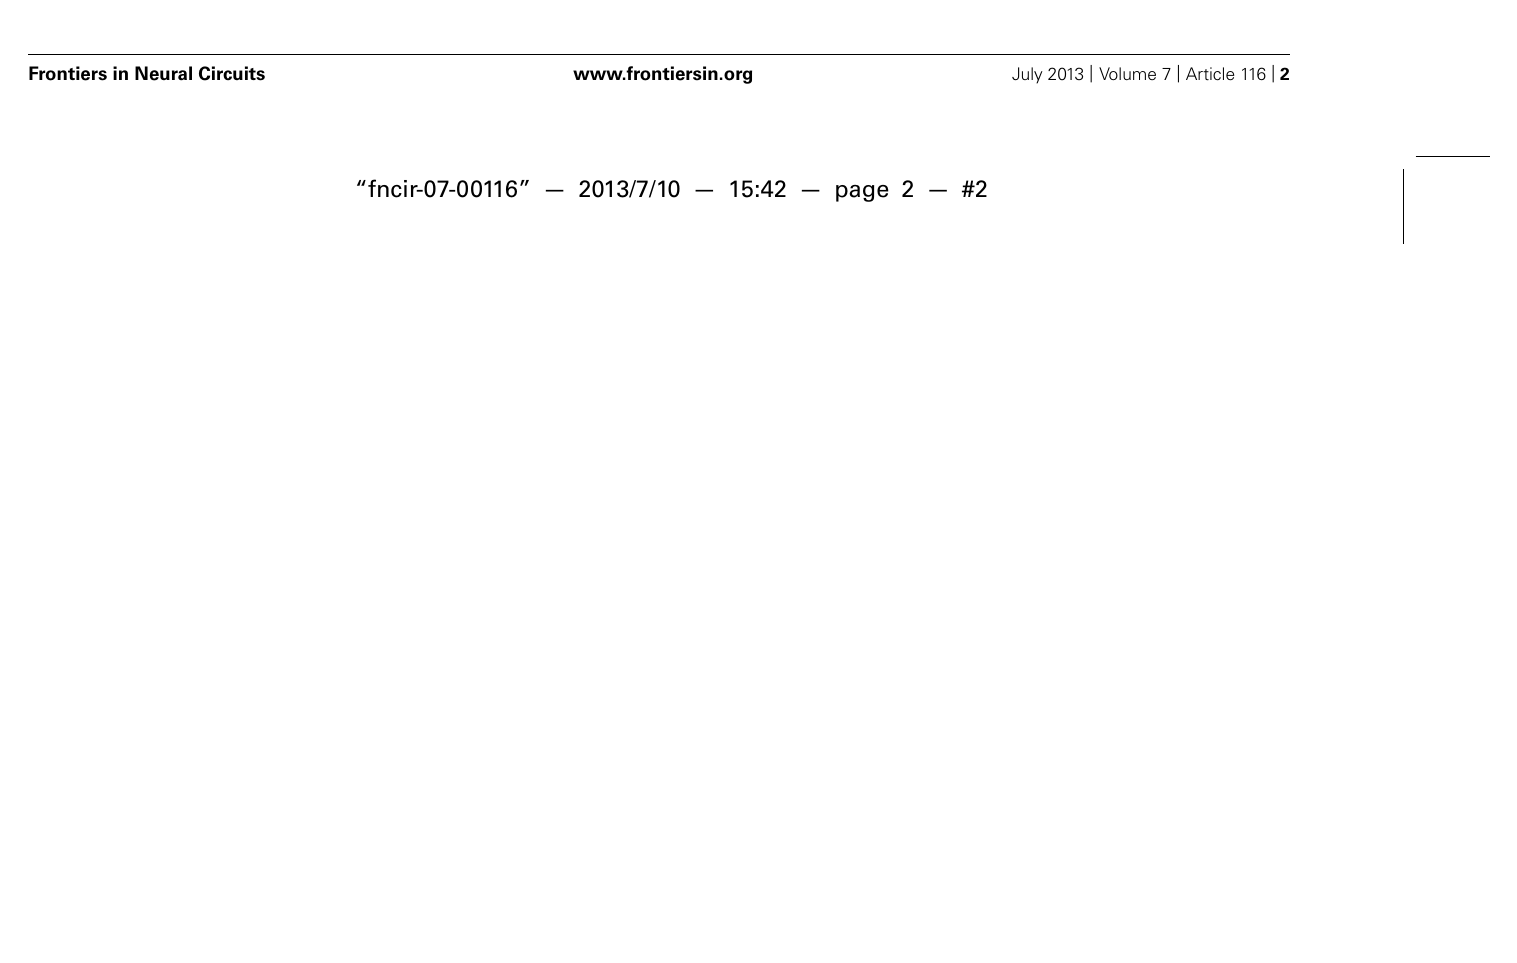
FIGURE 1 |The cell was intracellularly injected with biocytin and developed with DAB. (A) The cell body is located 921 micron below the cortical surface and the apical dendrite reaches the cortical surface (the tip of the apical dendrite appears in the next histological section). (B) A higher magnification reveals a typical layer 5 pyramidal cell.The deep location of the pyramidal cell strongly supports our claim that we measure from all cortical